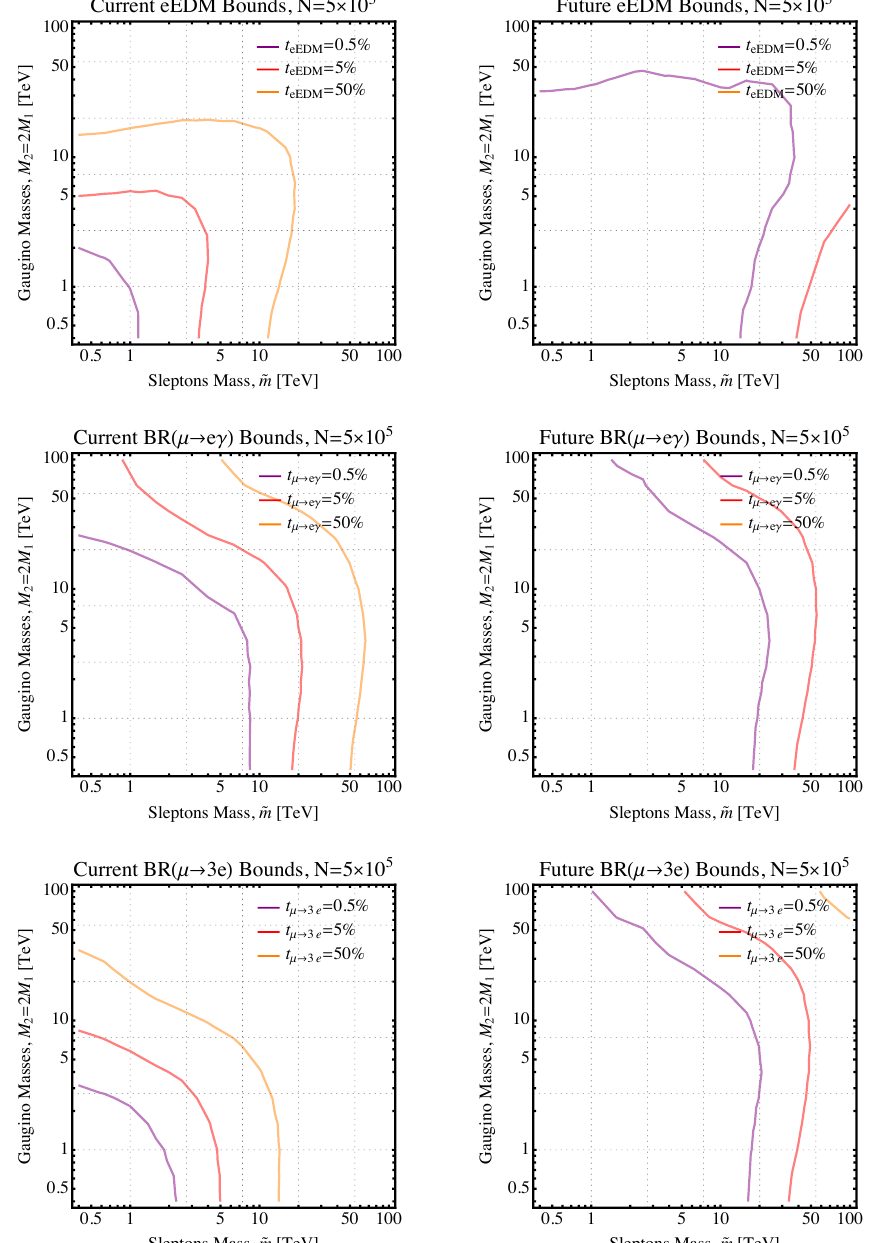
Figure 5 . Similar to figure 3 but for the charge assignment [ S 2 ] = − 3 and { [ L 1 ] , [ L 2 ] , [ L 3 ] , [¯ e ] , [¯ e ] , [¯ e ] } = { 3 , 3 , 3 , 4 , 0 , − 1 } (the third row of table 1 2 3